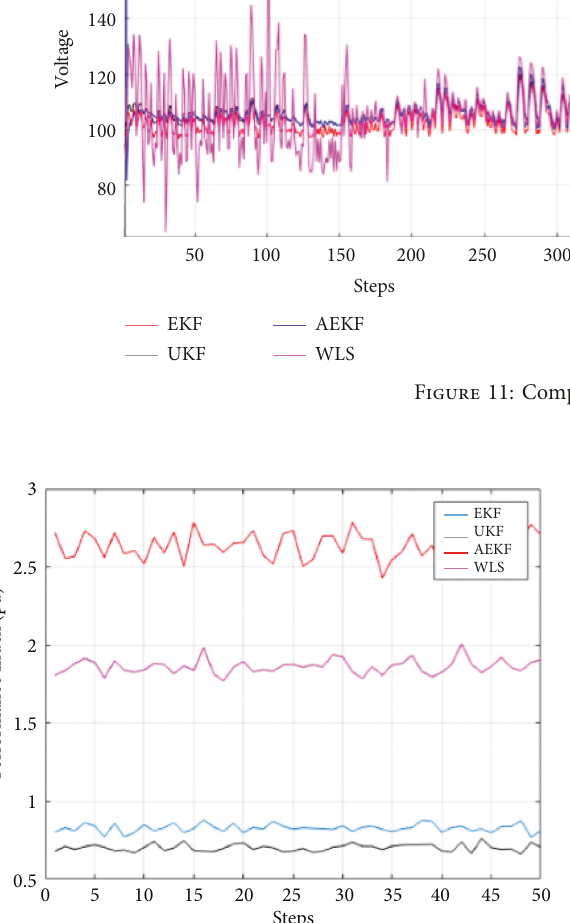
Figure 12: Estimator performance